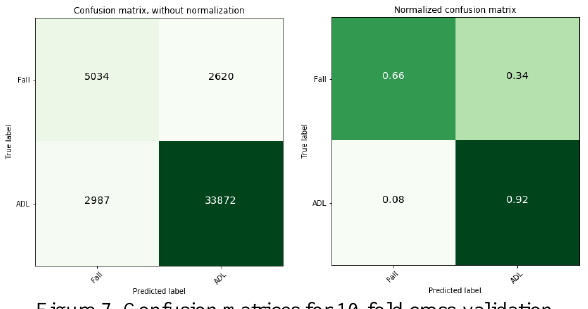
Figure 7. Confusion matrices for 10-fold cross-validation procedure for two-class classification problem under the